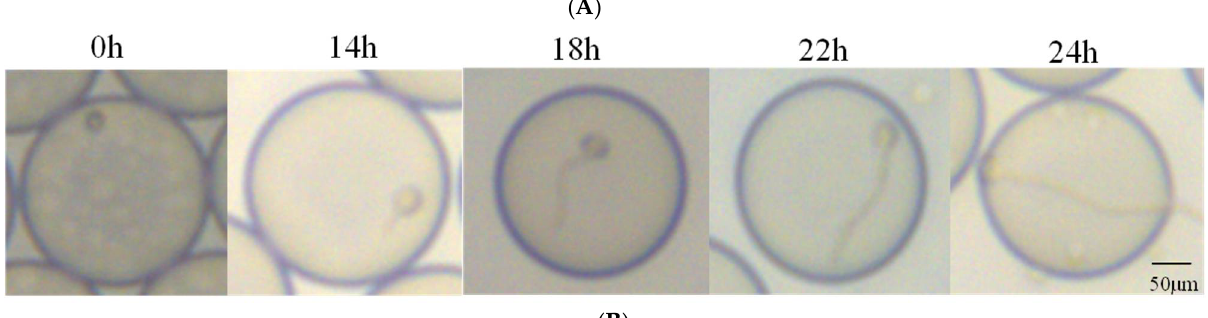
W 1 W 2 W 3 W 4 W 5 W 6 W 7 W 8 W 9 W 10 W 11 W 12 W 13 W 14 W 15 W 16 W 17 W 18 W 19 W 20 P a r e n t β - xy l o s i d a s e a c t i v i t i e s aga i n s t p N P X ( I U / m g )